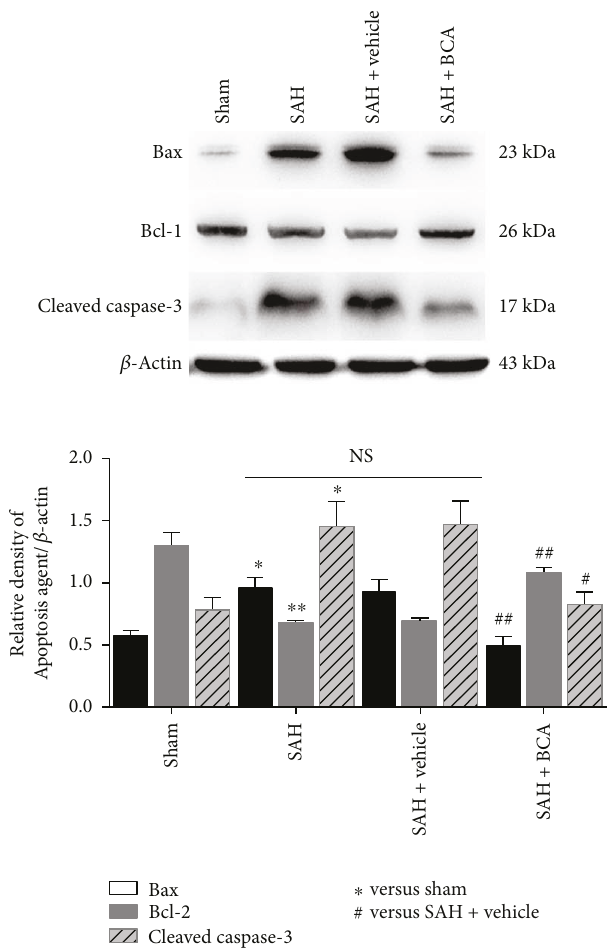
Figure 8: BCA administration suppressed the apoptotic process at 24 hours post SAH ( n = 6 , each group; ∗ P < 0 05 and ∗∗ P < 0 01 versus sham; # P < 0 05 and ## P < 0 01 versus SAH +vehicle; NS P > 0 05